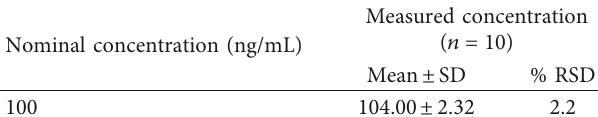
Table 6: Interday precision